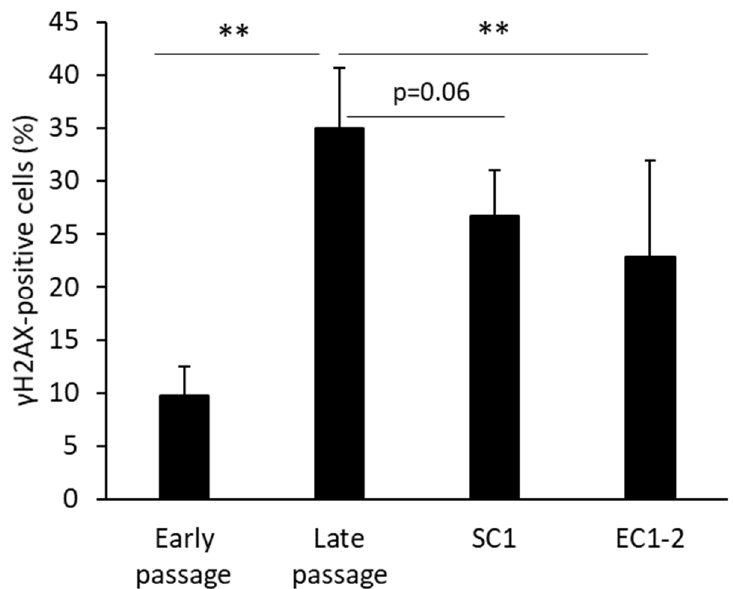
Figure 2. Effects of SC1 and EC1-2 on the ratio of γ H2AX positive cells. γ H2AX-positive cells and γ H2AX-negative cells are distinguished by measuring the fluorescence intensity of γ H2AX immunostaining. Data are reported as means ± SD of three independent experiments. **; p < 0.01 vs. Late passage group by Dunnett’s test.